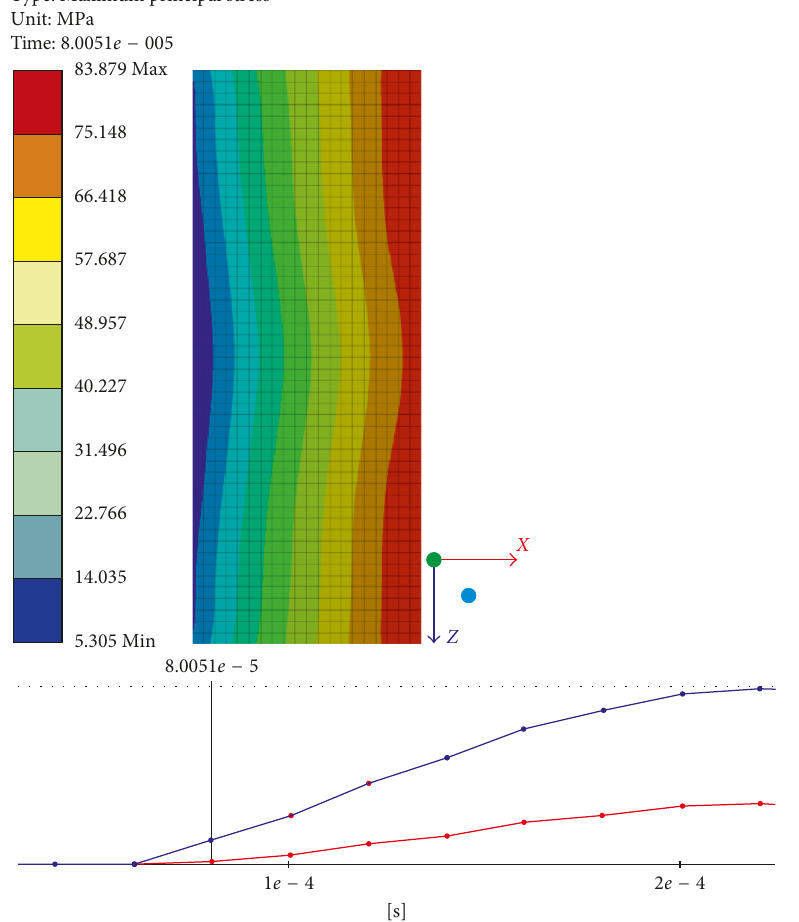
Figure 13: Distribution of Max Principal Stresses in the joint of the block sample when Max Principal Stresses reached tensile strength of the adhesive.